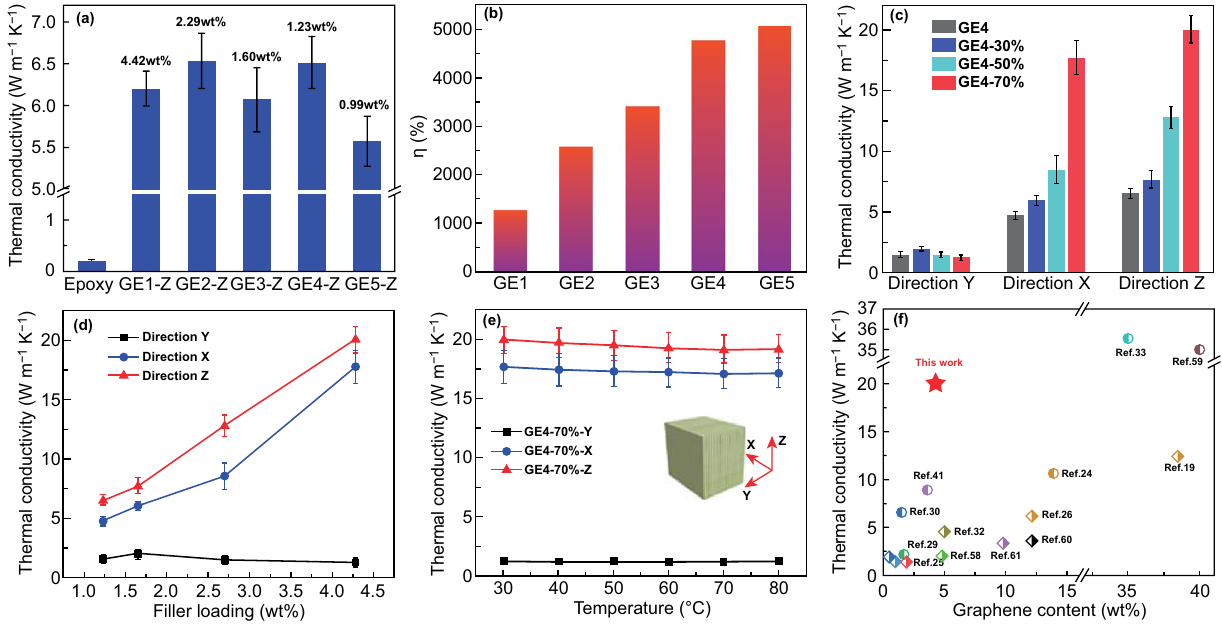
Fig. 4 a Thermal conductivities along Z‑direction, and b specific TCEs of graphene/epoxy composites. The data in a are graphene contents in their epoxy composites. c Comparison of thermal conductivities of GE4, GE4‑30%, GE4‑50%, and GE4‑70% in three directions. d Plots of ther‑ mal conductivity of the composites in three directions as a function of graphene content. e Thermal conductivities of GE4‑70% in three direc‑ tions at different temperatures. f Comparison of thermal conductivity of GE4‑70% in Z‑direction with those reported in the